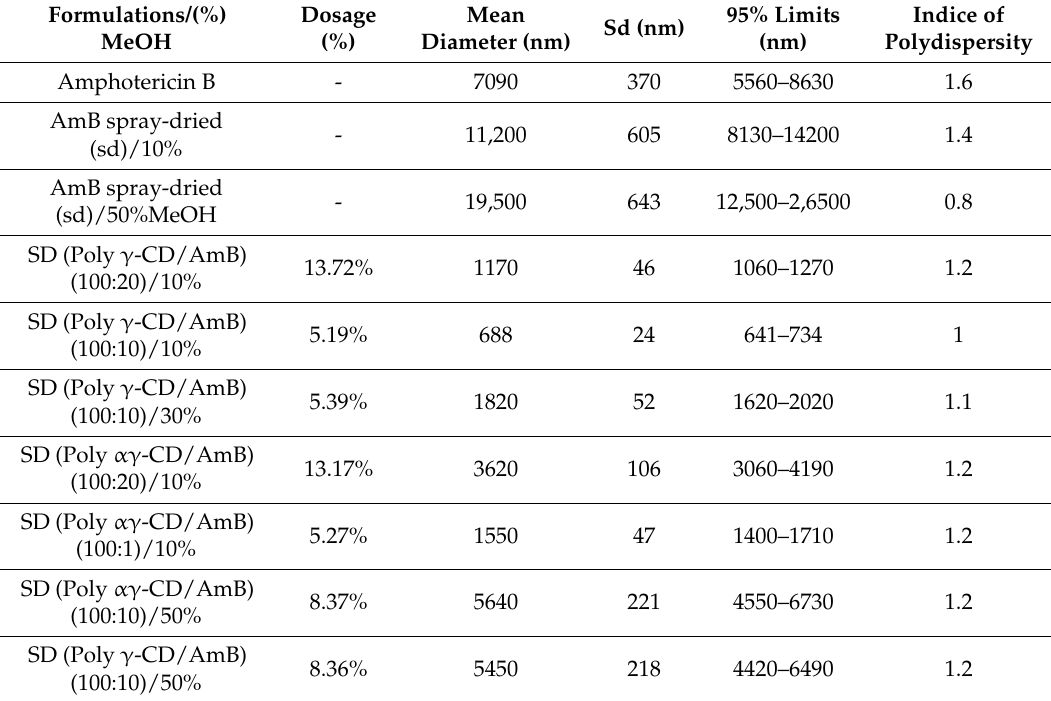
Table 1. Dosage (%) and mean diameter particles of amphotericin B drug (AmB), and different spray-dried formulations: solid dispersions (SD), γ -cyclodextrin based polymers (Poly γ -CD) and αγ -cyclodextrin based polymers (Poly αγ -CD). 95% limits mean the limits of size of 95% of the particle